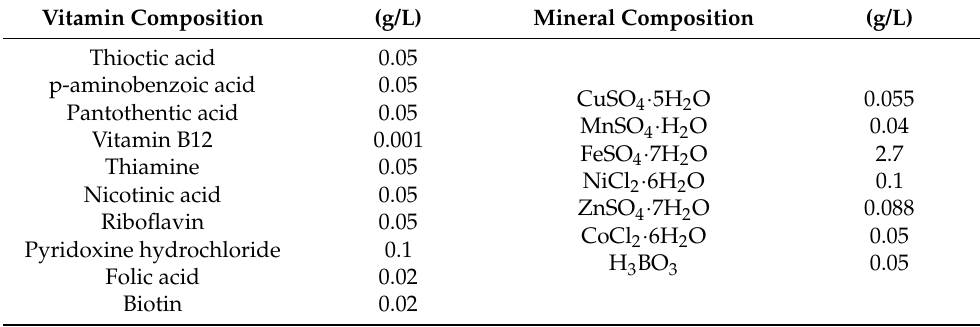
Table 2. The composition of vitamins and minerals solutions in the synthetic wastewater. Vitamin Composition (g/L) Mineral Composition